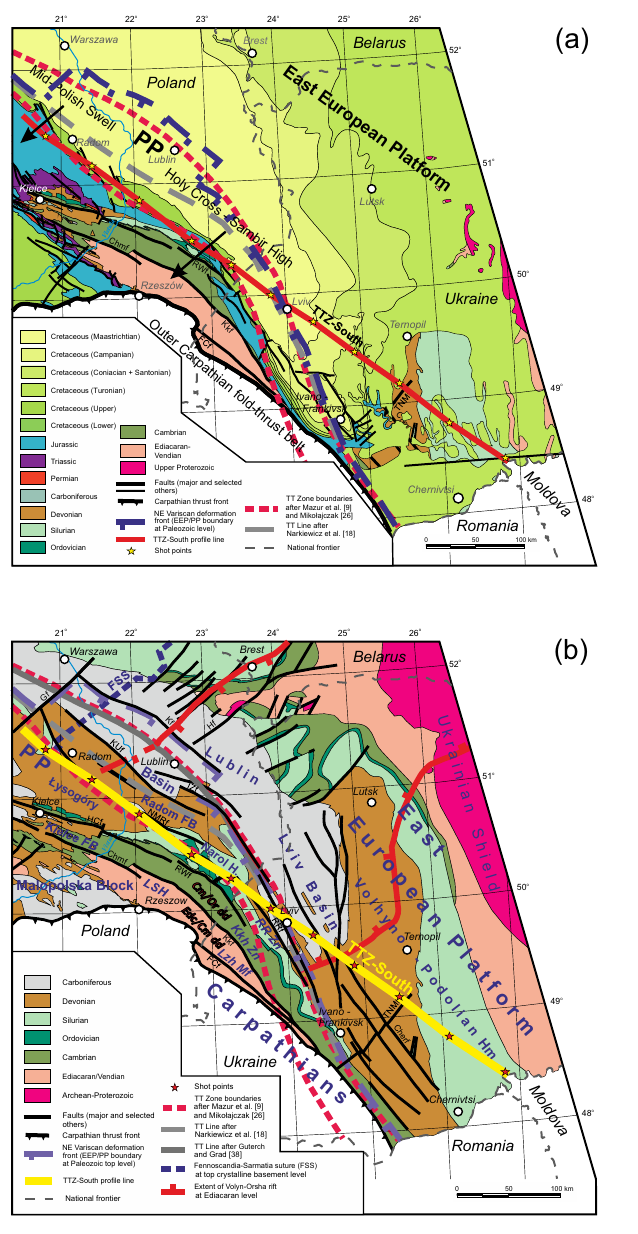
Figure 3. Geological situation of the TTZ-South profile ( a ) on base-Cenozoic subcrop geological map, ( b ) on base-Permian subcrop geological map. The maps are based on various sources, most notably on [37–42], and show the approximate location of (1) the boundary between the Precambrian East European (EEP) and Paleozoic (PP) platforms at the top Paleozoic level, (2) the Ediacaran Orsha-Volhynia rift basin (after [23,42]), (3) the Fennoscandia-Sarmatia suture (FSS) on top of the crystalline basement (based on modified data from [23,25,42] combined with results presented in this paper) and (4) the TTZ or TTL according to various authors. The location of the figures is marked by the red quadrangle in Figure 2a. Abbreviations: Cm/Or dd—Cambrian/Ordovician deformation domain; Edc/CM dd—Ediacaran/Cambrian deformation domain; f—fault/fault zone, FB—fold belt, H—high, Hm—homocline; Kkh—Kokhanivka; LSH—Lower San horst, Lzh—Lezhaisk;